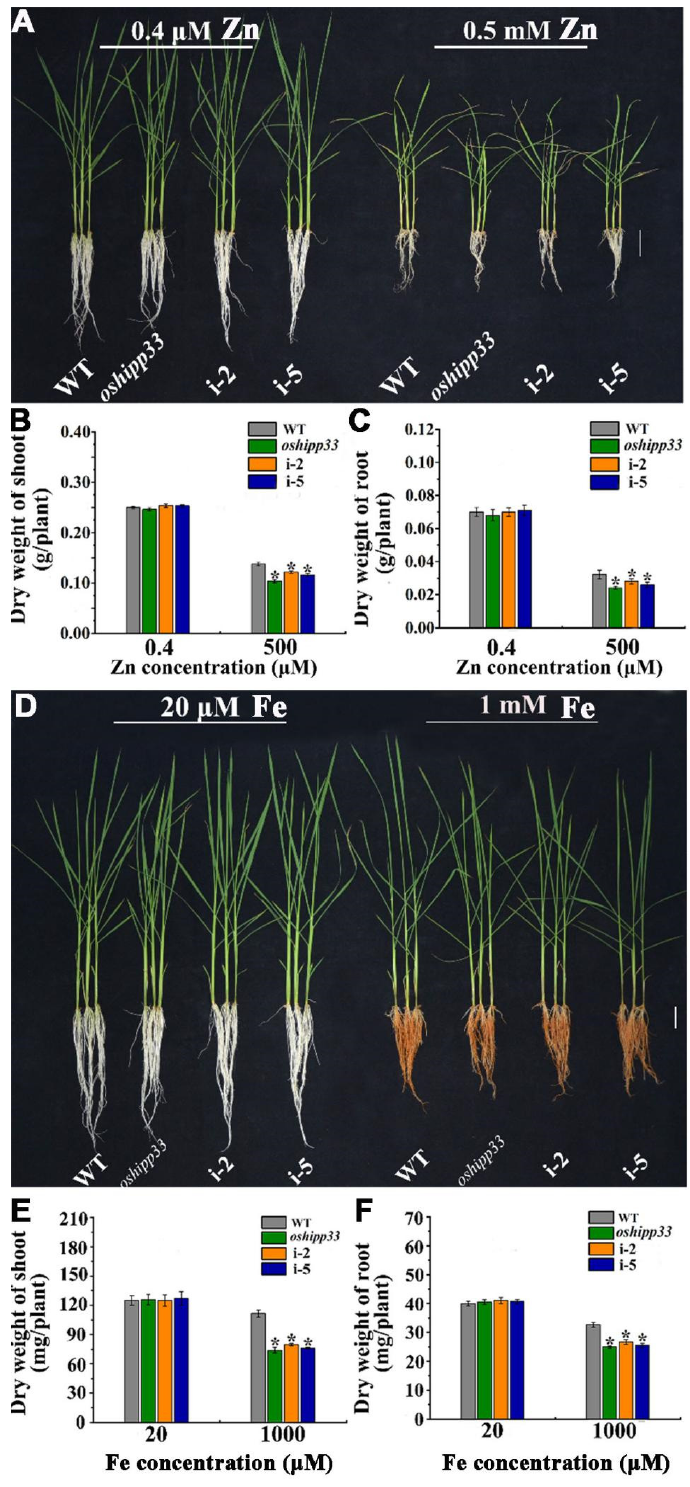
Figure 6. Growth phenotypes of OsHIPP33 mutant, RNAi lines (i-2 and i-5) and wild-type (WT) under excessive Zn and Fe stress. Two-week-old rice seedlings were exposed to the nutrient solution containing 0.4 µ M Zn (normal) and 500 µ M Zn (excess) ( A – C ) or 20 µ M Fe (normal) and 1000 µ M Fe (excess) ( D – F ) for two weeks. When harvested, the rice plants were photographed and phenotypically analyzed. The dry weight of shoot and root of the plants under excess Zn and Fe was estimated. Scale bars: 3 cm for ( A , D ). The vertical bars indicate the means of biological triplicates and the asterisks show the significant difference between the mutant lines and WT ( p <